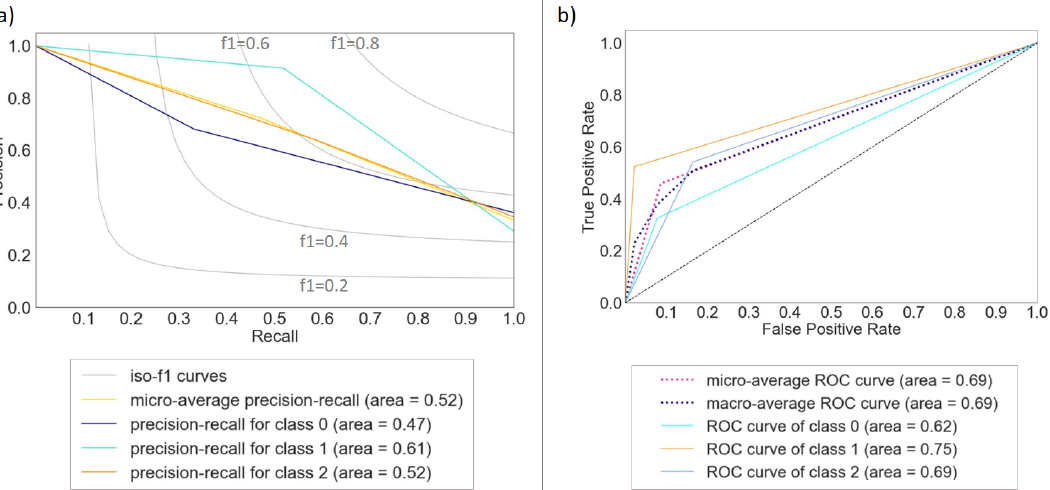
Figure 8. Random forests simulation results: ( a ) precision–recall curve; ( b ) ROC curve.